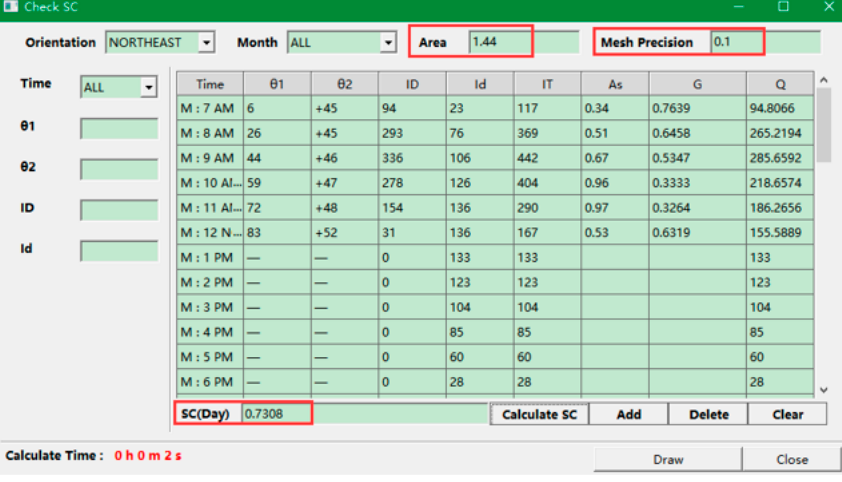
Figure 14. SC2 calculation by using the proposed digital method.